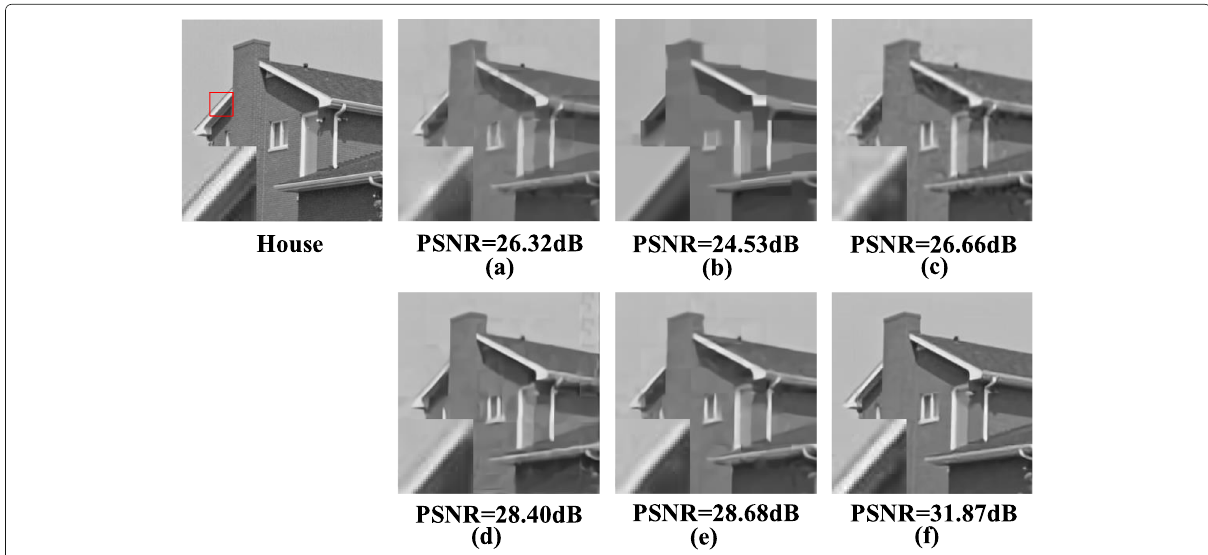
Fig.10 The reconstruction results of House at the measurement rate of 0.1 with BM3D. a TVAL3. b DAMP. c ReconNet. d DR 2 -Net. e CSRNet. f